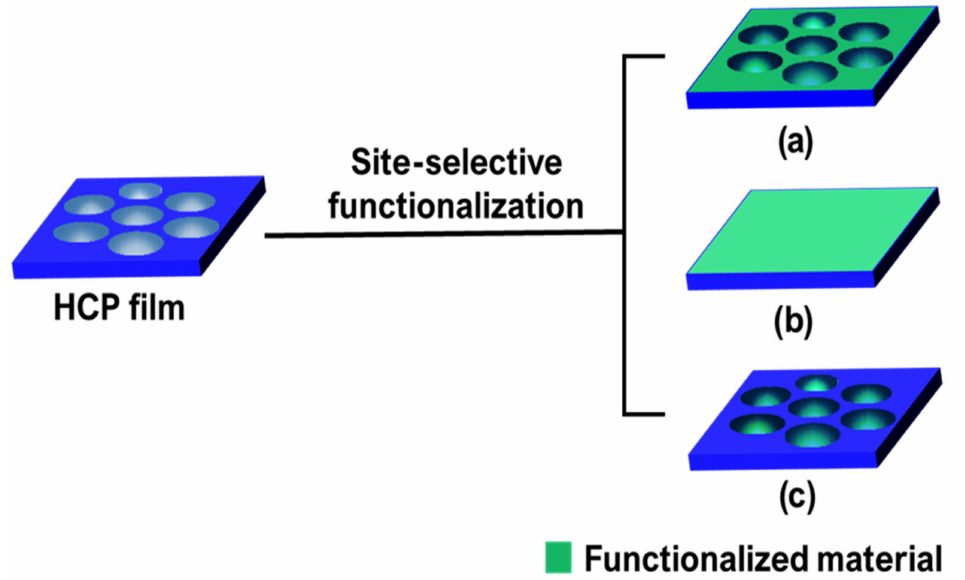
Figure 2. Possible site-selective functionalization of HCP films by modified BF method. ( a ) Top, ( b ) bottom, and ( c ) pore surface